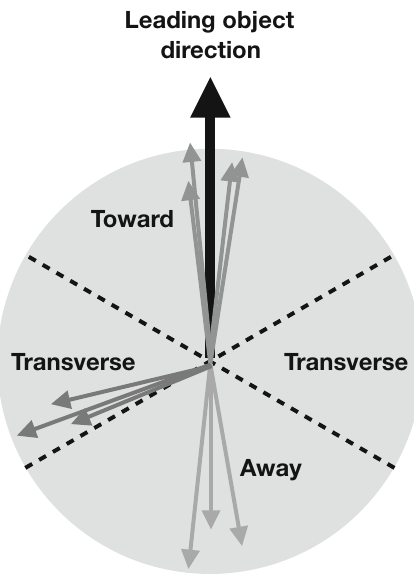
Fig. 1 Illustrationofthedifferent φ regions,withrespecttotheleading object in an event, used to probe the properties of the UE in measure-